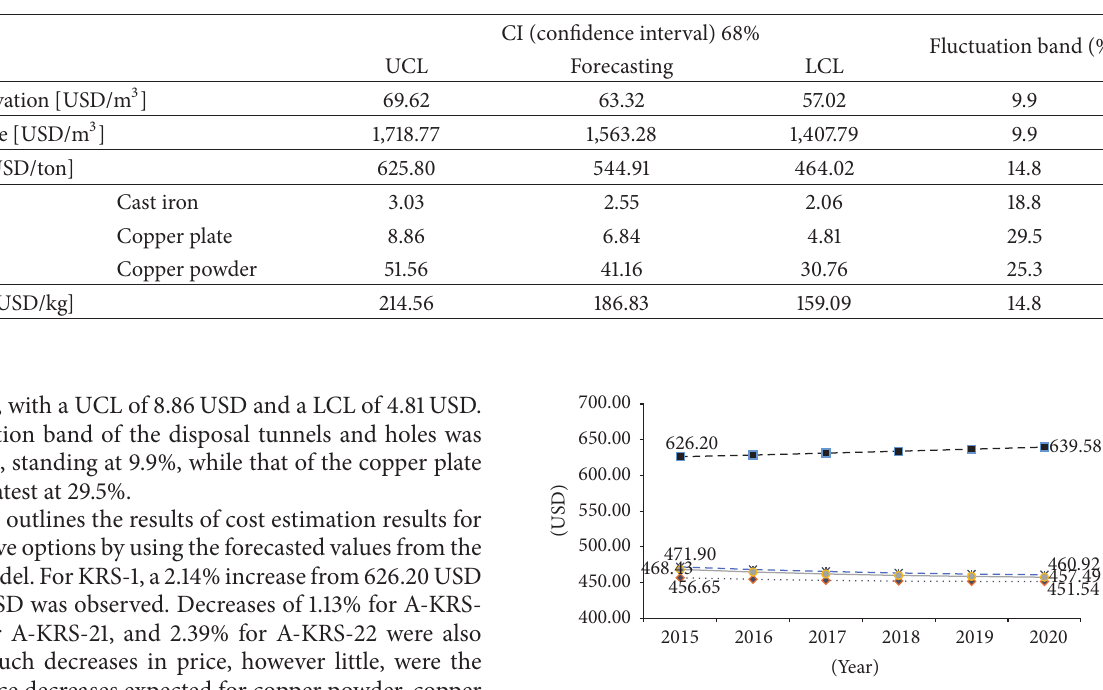
Table 6: The results of price forecasting at confidence interval 68%—year 2020.